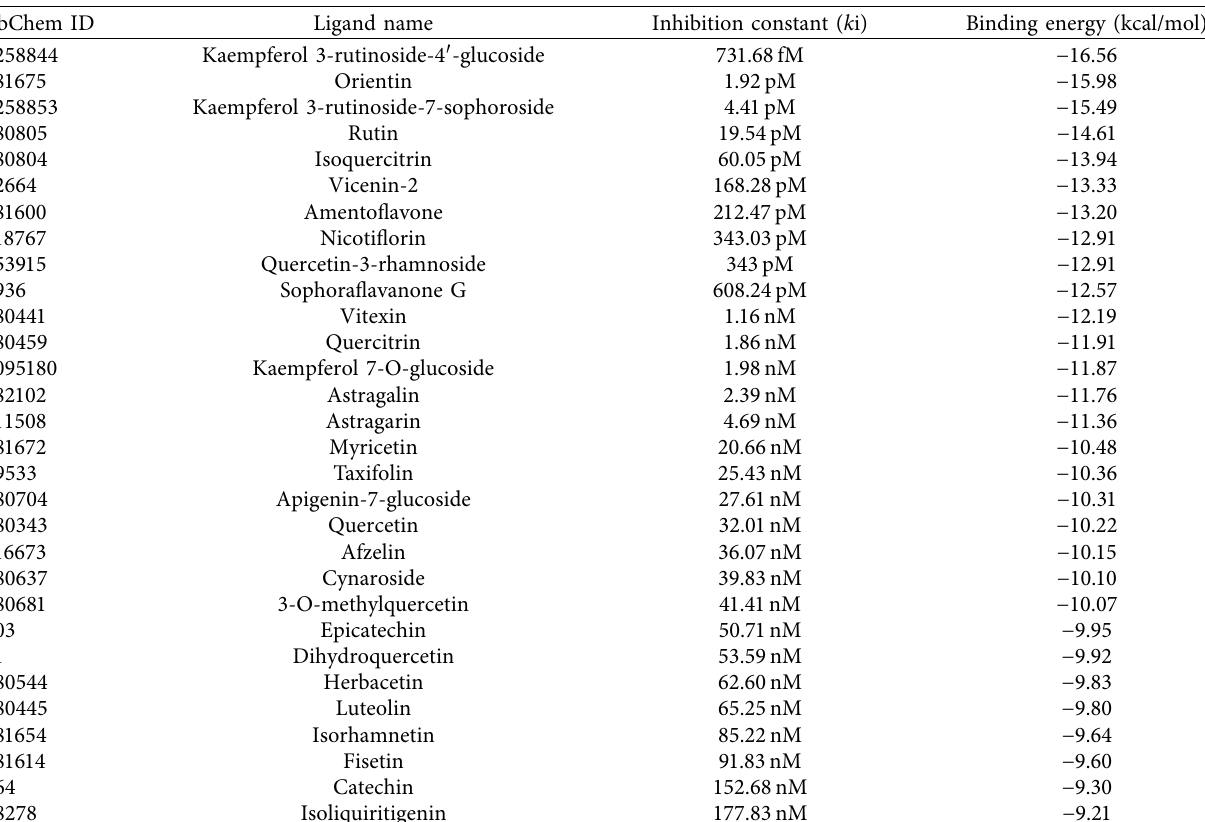
Figure 2: Estimated binding energies between these study’s most potent MAPK3 inhibitors compared to the standard drug (purvalanol) achieved from the AutoDock tool. Te x -axis illustrates the compound’s names, and the y -axis shows their estimated binding energies (kcal/ mol). Te green diamond presents the purvalanol, while yellow, orange, and red spots represent favonoids with inhibition constant values at nanomolar, picomolar, and femtomolar scales, respectively. MAPK3, mitogen-activated protein kinase 3. Table 1: Binding energy and inhibition constant values for 46 favonoids and a positive control inhibitor docked to the MAPK3 active site, achieved from the AutoDock